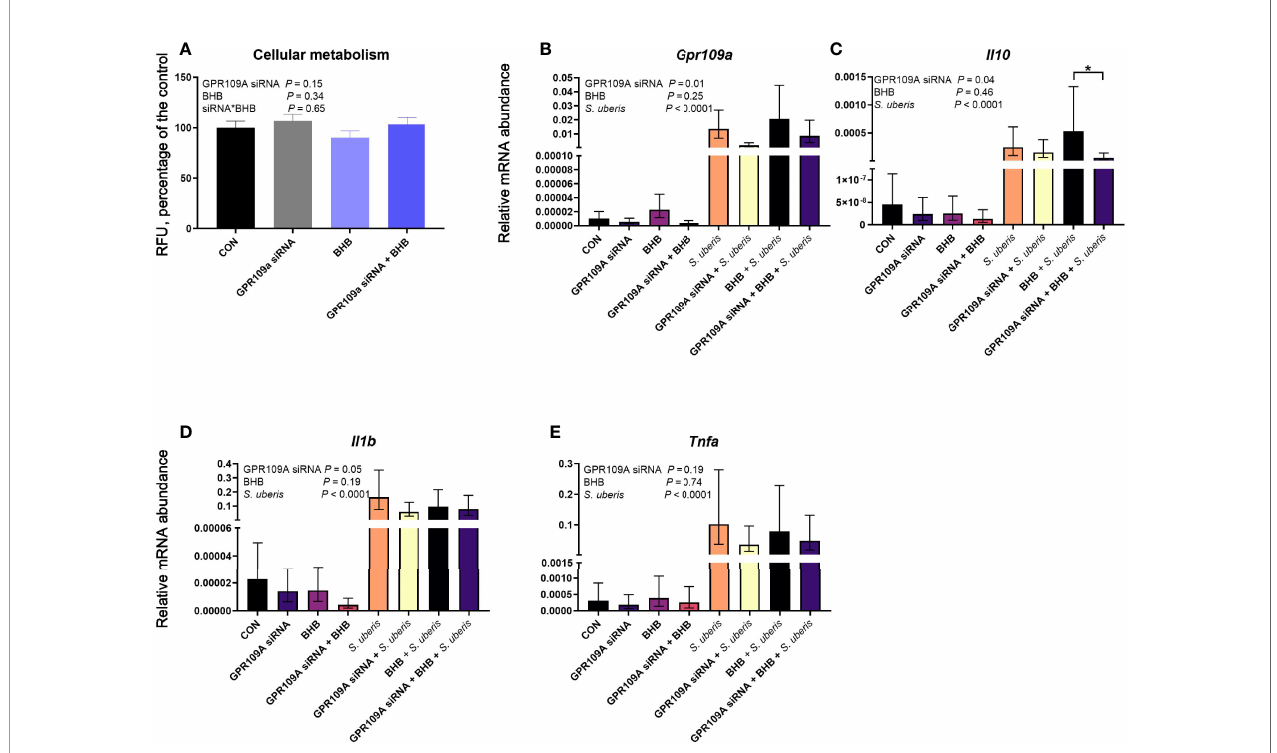
FIGURE 5 | GPR109A silencing reduced Il10 from mouse macrophages (RAW 264.7 cell line) challenged with S. uberis . Data were analyzed as a factorial (n = 8 or 9 replicates/treatment group for cellular metabolism and transcript abundance, respectively) with fi xed effects of GPR109A siRNA, BHB treatment, and S. uberis challenge (transcript abundance only). Cells were either transfected with 25 nM GPR109A siRNA or with a scrambled control for 24 h. Following transfection, cells were treated with media containing either 0 or 1.8 mM BHB and were challenged with 2 × 10 7 cfu S. uberis (0140J strain) or not challenged for 3 h. Cellular metabolism (A) was assessed by measuring fl uorescent resoru fi n formation in relative fl uorescent units (RFU) expressed as a percentage of the control. Transcript abundance of target genes ( B , Gp109a ; C , Il10 ; D , Il1b ; E , Tnfa ) were normalized to B2M using the Pfaf fl (24) equation. * P ≤